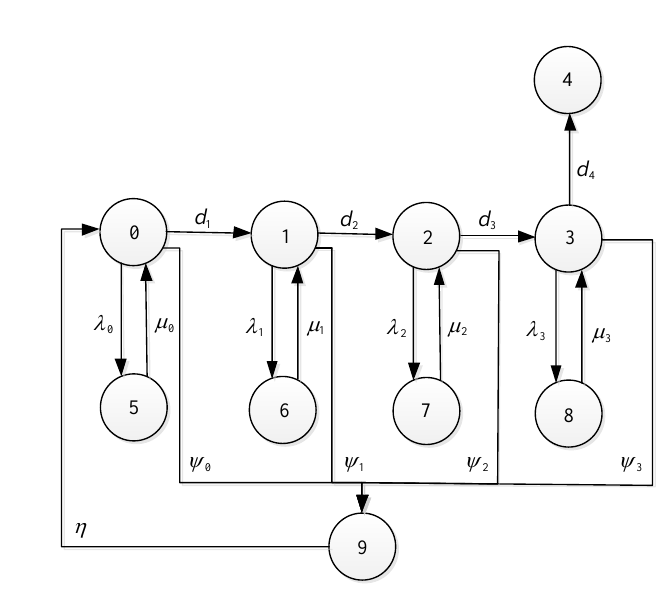
Figure 3. Example of multi-state degraded system.